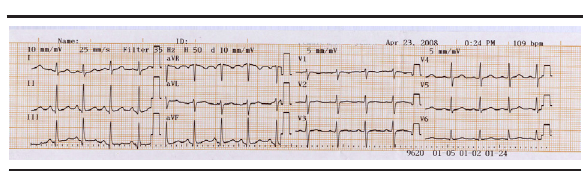
figure 5. ecG with reversal of limb and precordial limb leads showing normal wave pattern with sinus tachycardia without any conduction abnormalities or any other significant abnormality